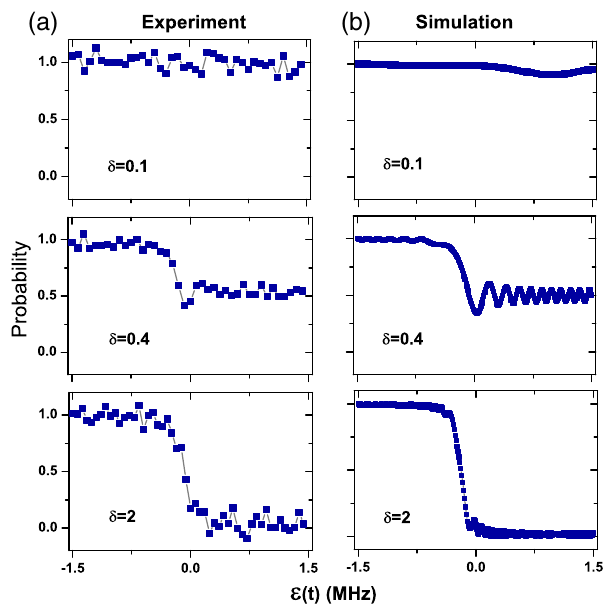
FIG. 2. Dynamics of the LZ tunneling. Measured (left) and simulated (right) dynamics of LZ tunneling under the driving field " ð t Þ ¼ " cos ð 2 (cid:2)!t Þ for different values of the adiabaticity parameter (cid:3) ¼ (cid:1) 2 ="! . To measure this curve, we set " ¼ 1 : 5 MHz and (cid:1) ¼ 0 : 11 kHz and used different ! . For the case (cid:3) (cid:3) 1 , the system remains in j 0 i , while for (cid:3) (cid:5) 1 , the system evolves adiabatically with the driving field.